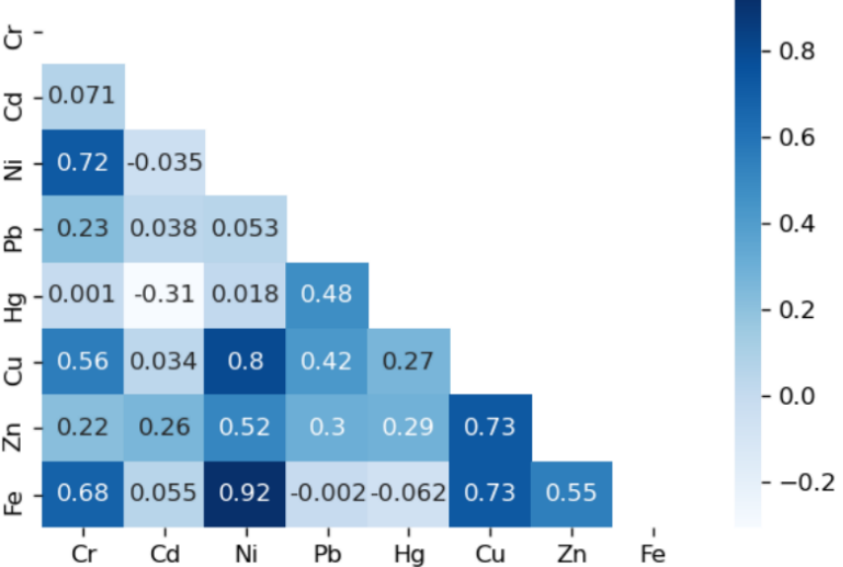
Figure 4. Heatmap of metal correlation coefficients of the sediments in water bodies in the southern area. n = 40. Correlation coefficients above |0.4| are statistically significant at 0.01 and above |0.3| at 0.05.